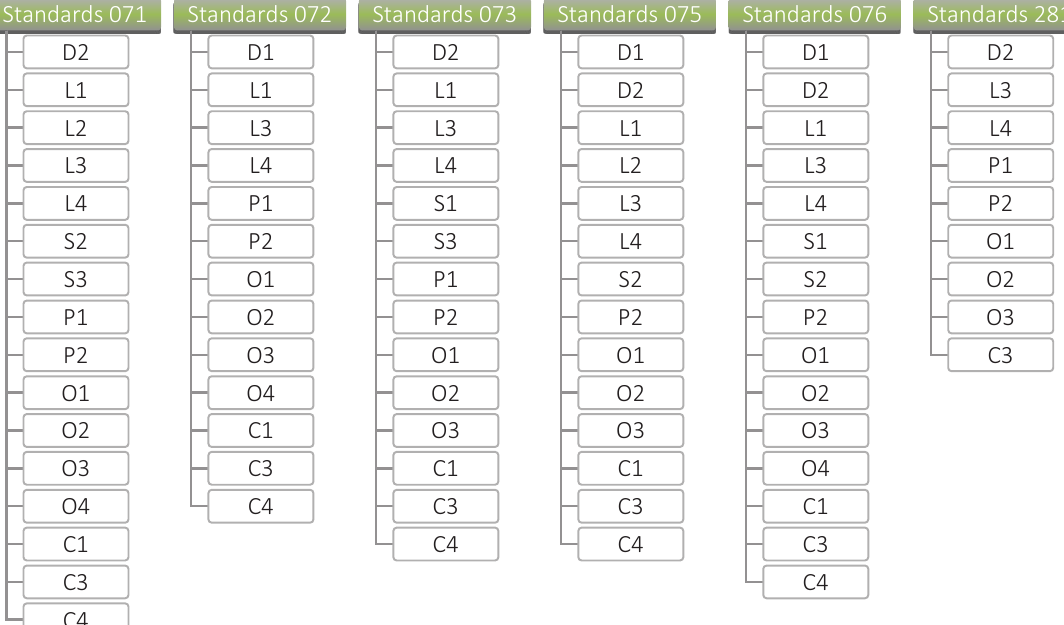
Figure 7. Recommendations for the addition to the Standards of Ukraine by fields of knowledge 07 “Management and administration” and 28 “Public management and administration” to update managerial